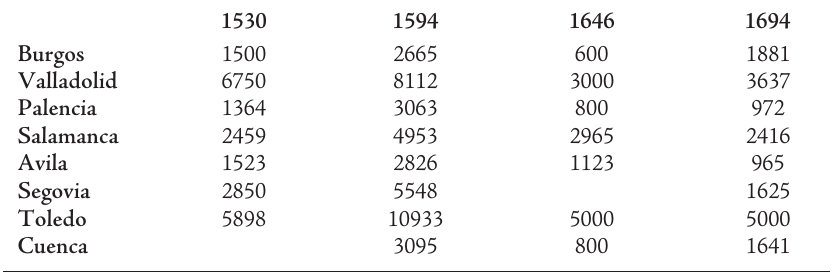
Table 2 – Population in Some European